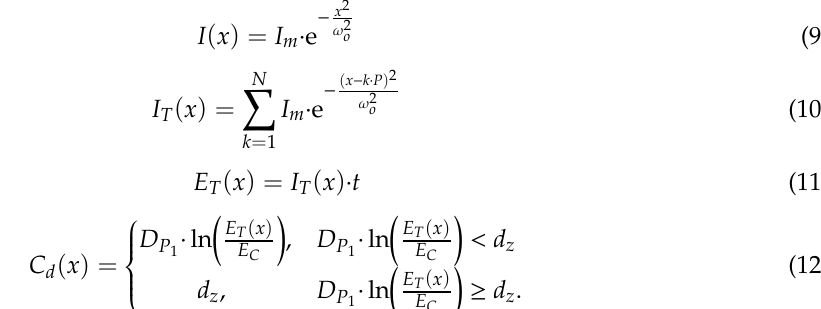
µ m. Figure 3c,d show the e ff ect of exposure time on exposure energy and lateral dimensions for line projected by a nine micromirrors with all of them turned on when the middle three mirrors are turned o ff